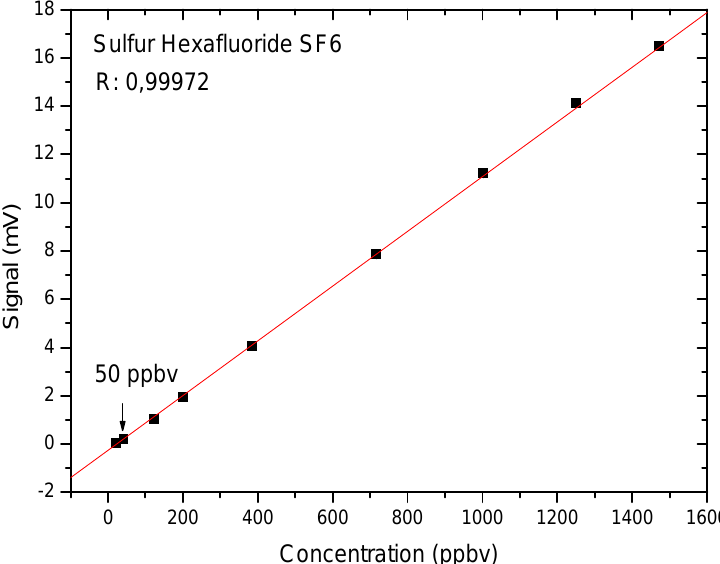
Figure 5. Calibration curve for sulfur